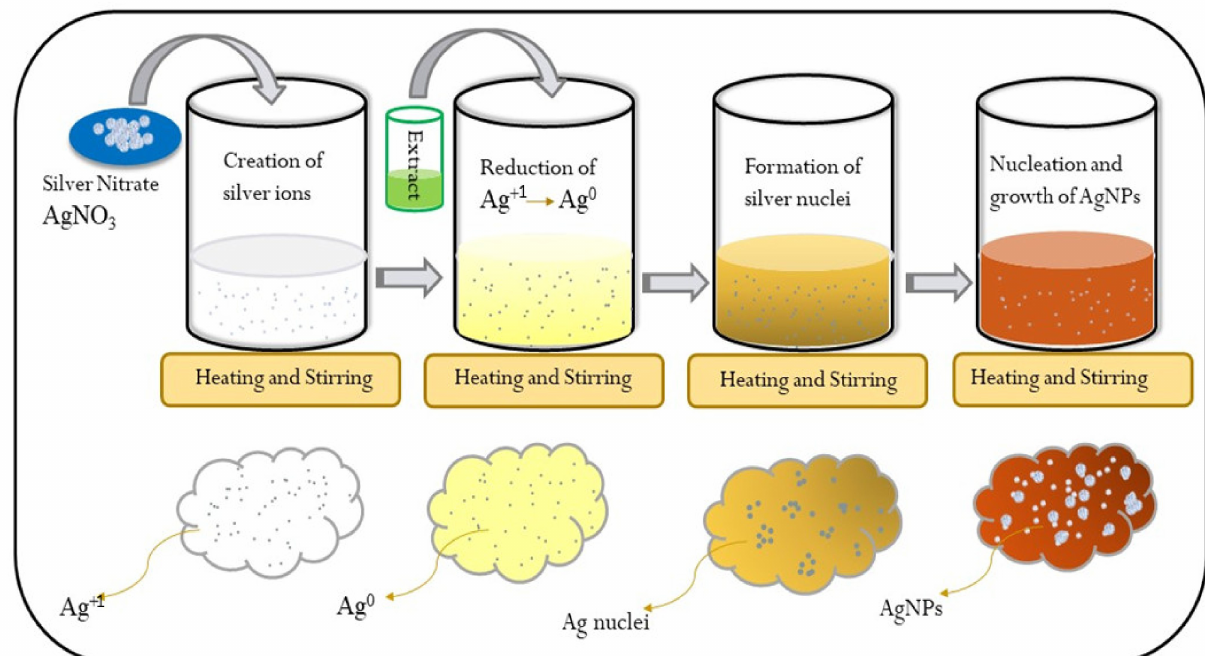
Figure 3. A synthesis mechanism of extract mediated